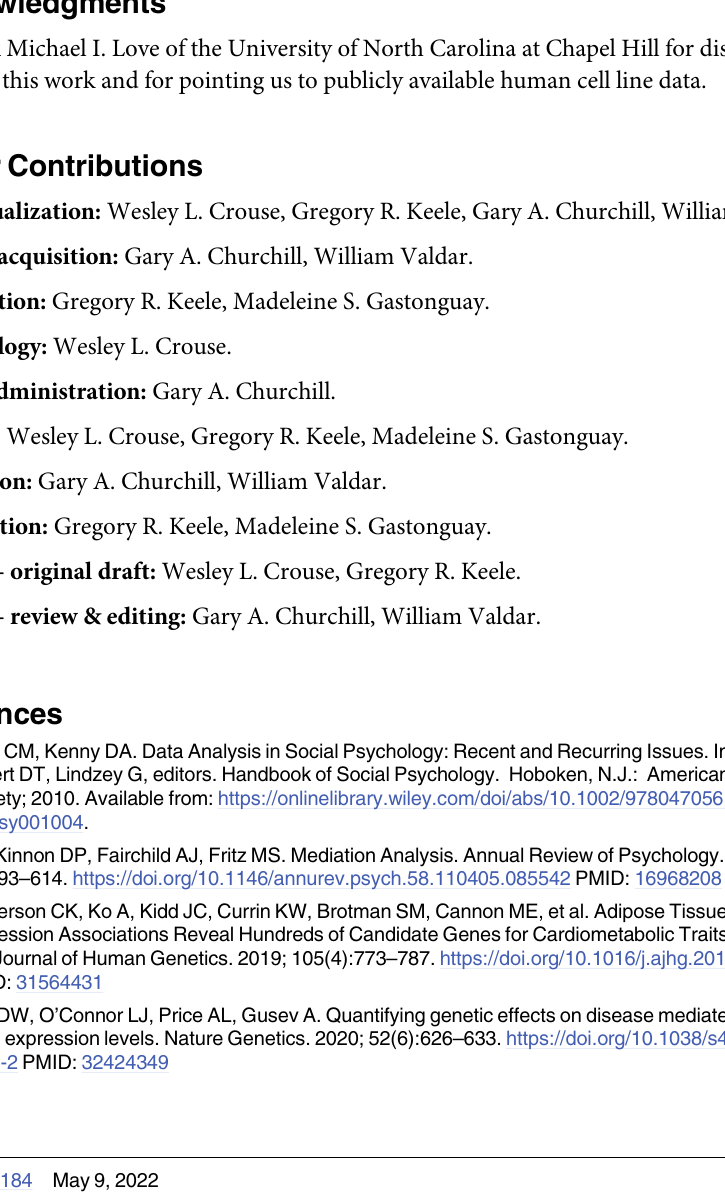
S1 Table. Features of the evaluated causal inference